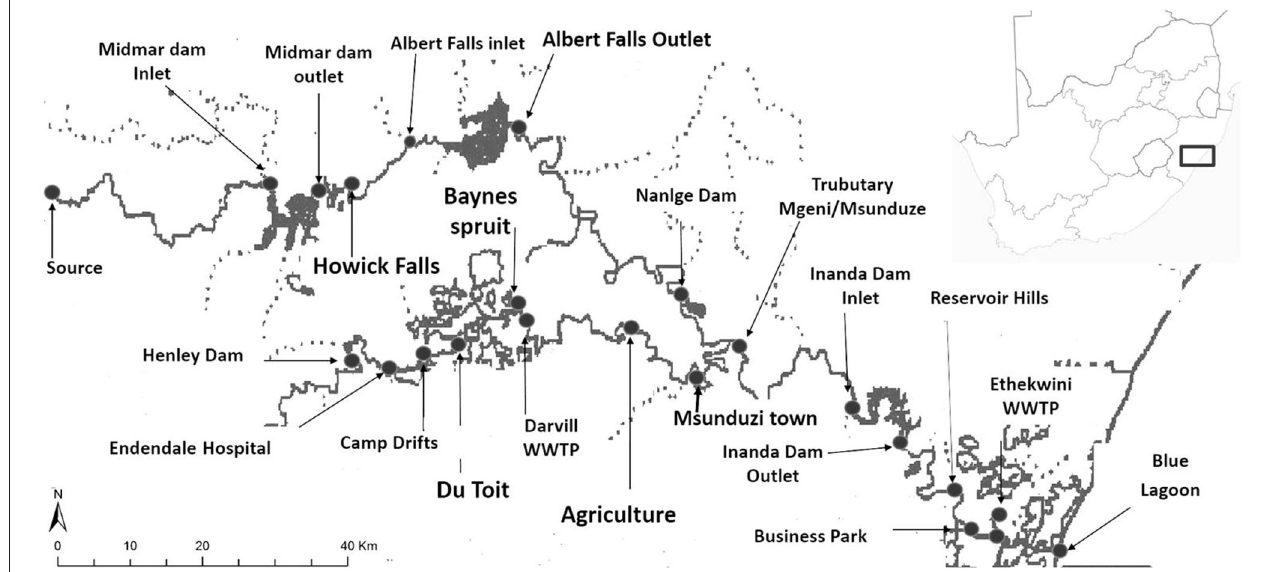
FIGURE 1 | Sampling area of the Mgeni and Msunduzi rivers in KwaZulu-Natal, South Africa. Grab samples were collected at all points and using the developed method described in this work (map was drawn using GIS software shapefile) (Gumbi et al., 2019).